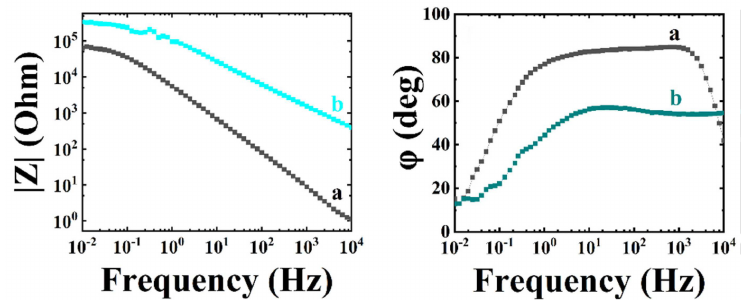
Figure 5. Tafel plots for ( a ) uncoated substrate and ( b ) coated from 5 g L − 1 PVDF suspensions con- taining 1 g L − 1 GA and annealed at 200 °C. PVDF films were obtained at deposition time of 5 min and deposition voltage of 100 V.